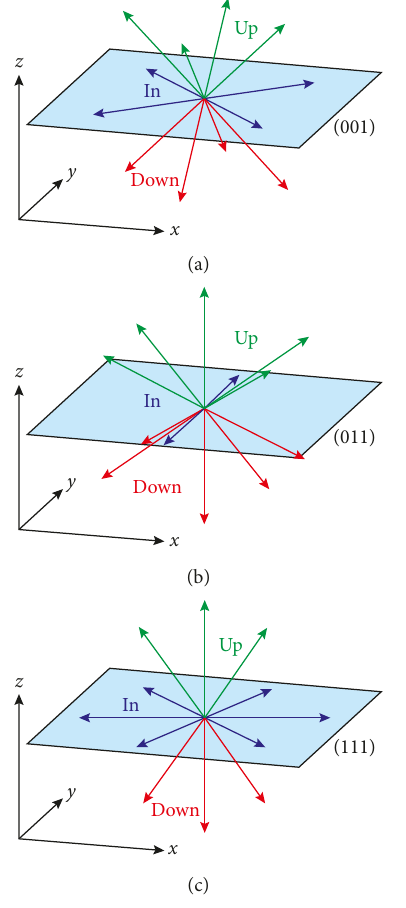
Figure 2: Bond orientation of bcc crystal structures: (a) (001), (b) (110), and (c)